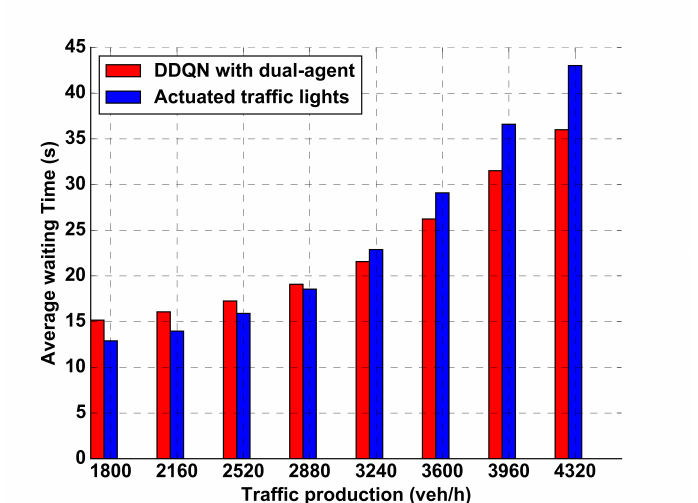
Figure 11. Comparison performance of average waiting time between DDQN with dual-agent and actuated traffic signals.